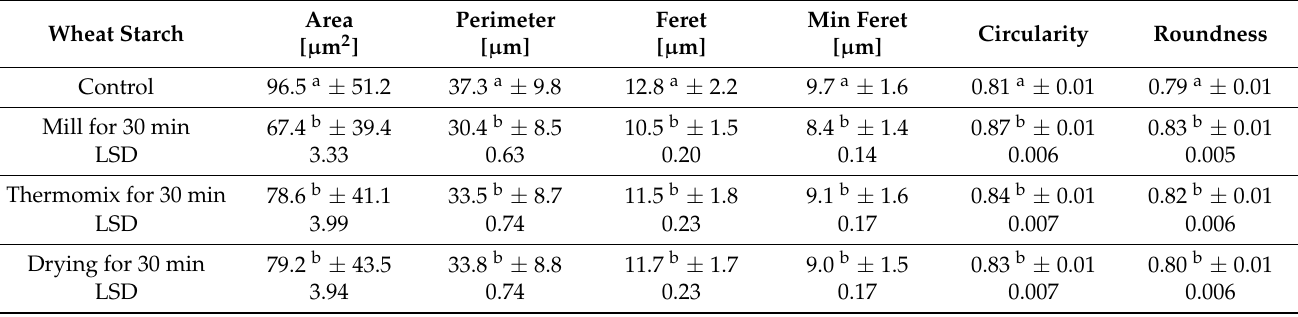
Table 4. Comparison of measurements of wheat starch granules before (control) and after grinding and